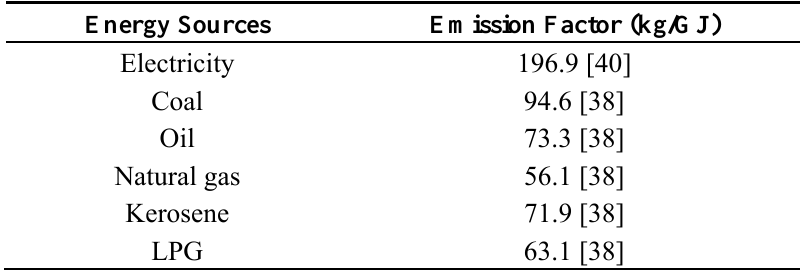
Table 3. Emission factors of energy sources for